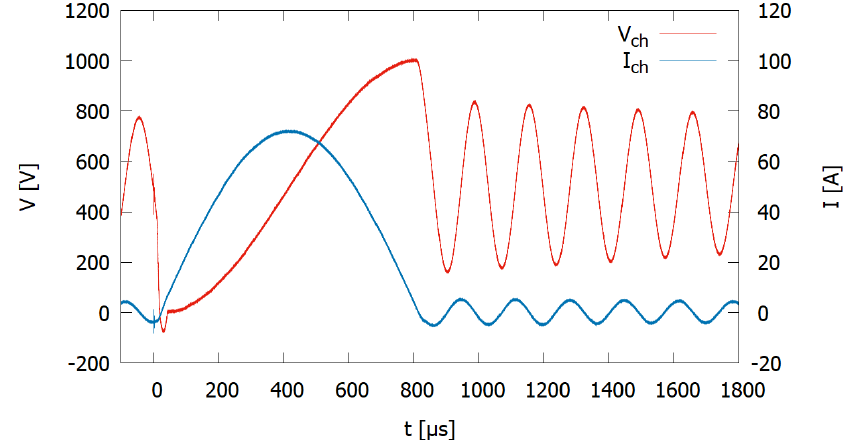
Figure 24. Measured charging voltage and the charging current at the charging input terminal of an 8-stage Marx generator, on-time of the solid-state switches: 22 µs [10].